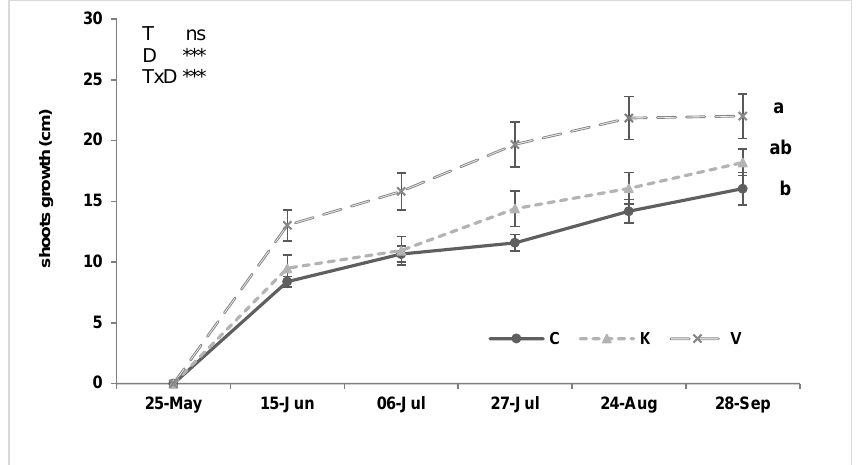
Figure 2. Effects of kaolin (K), di-1-p-menthene (V) on shoots growth during the growing season. C: control. Different letters indicate significant differences according to Duncan’s multiple-range test ( p = 0.05). * indicates the first application of the anti-transpirants. Vertical bars indicate ± SE of the means, n = 10 plants for treatments. Asterisks indicate significant effect of biostimulant treatment (T), days of measurements (D), and their interaction (T × D), according to two-way ANOVA (ns, *, **, *** non-significant or significant at p ≤ 0.05, 0.01, and 0.001, respectively)